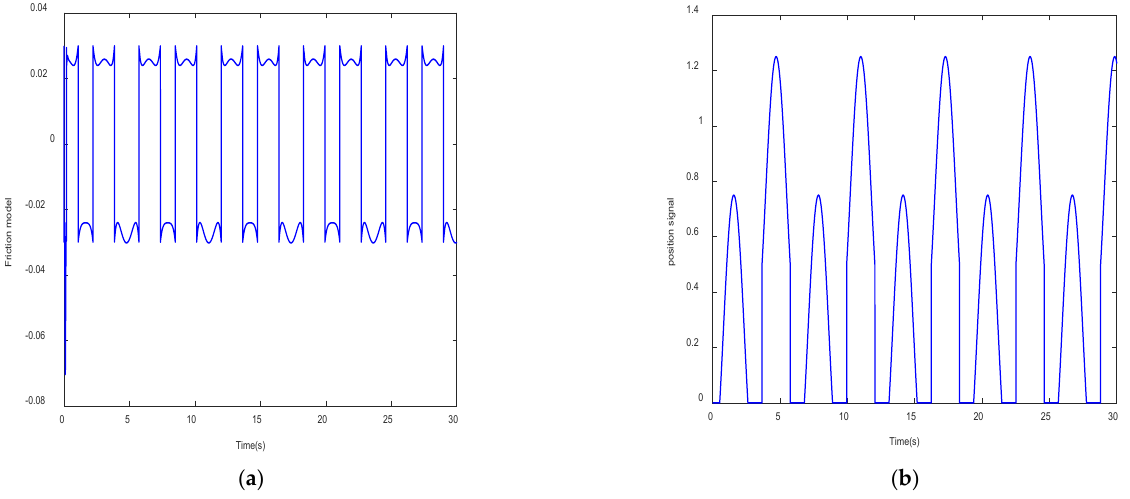
Figure 14. Sensitivity curve for the radar system with respect to its input.